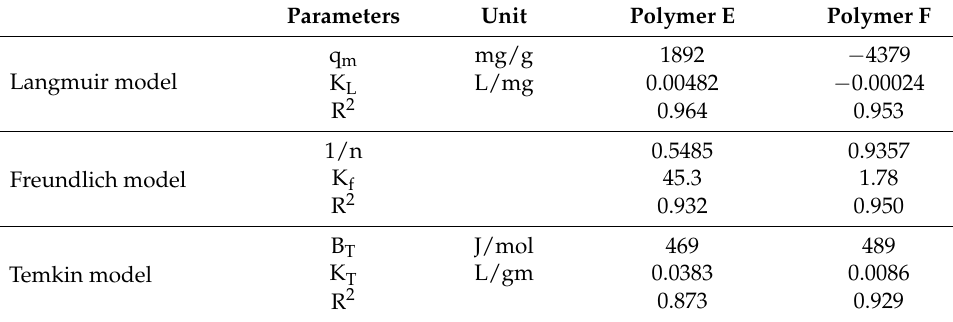
Figure 12. Isotherm model plots of both polymer F and E for MB adsorption. Experimental conditions were: adsorbents hydrogel dose 50 mg in 100 mL; pH 7, at RT. Table 5. Polymers E and F isotherm parameters for MB adsorption at 25 °C.